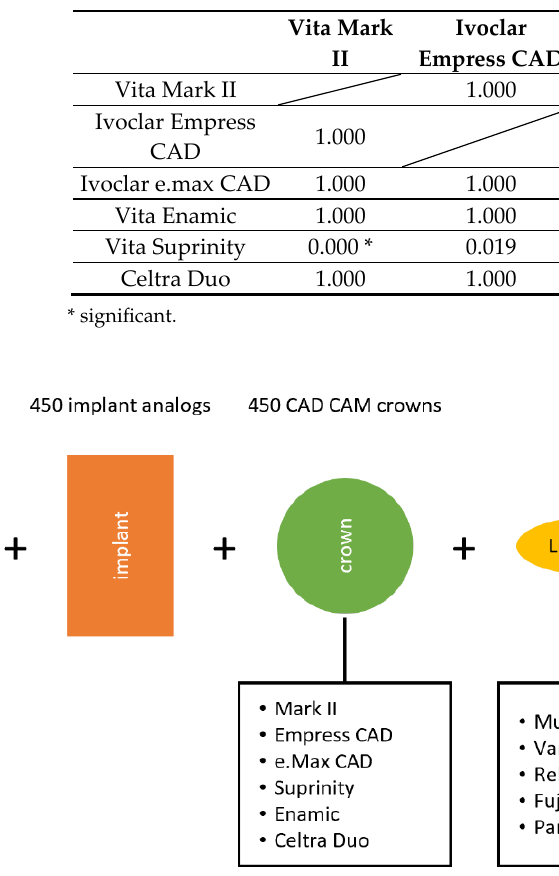
Figure A1. Schematic representation of the methodology.